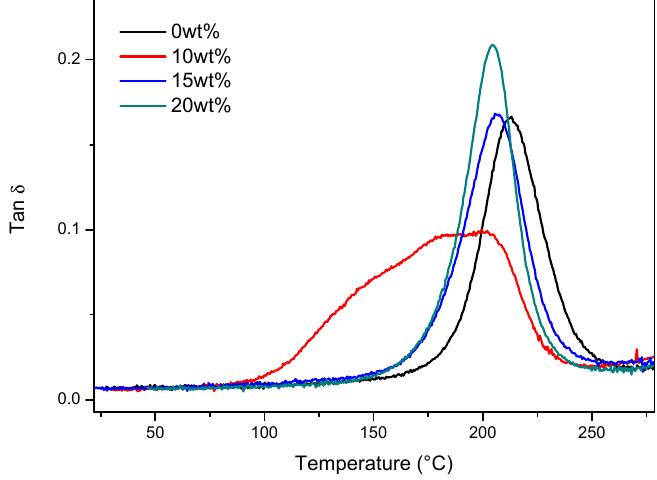
Figure 8. Tan δ versus temperature curves for the laminate with different veil contents after post-curing.